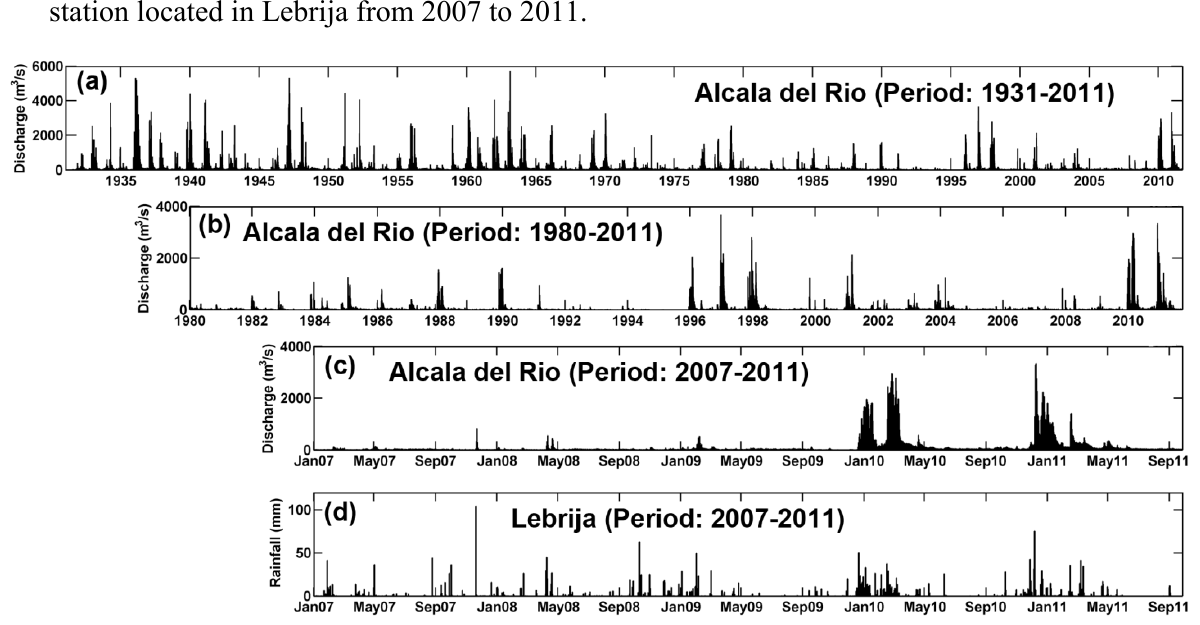
Figure 2. ( a,b,c ) Daily average river discharge (in m 3 /s) from the Alcalá del Río dam during different time periods; ( d ) Daily rainfall (in mm) measured by a meteorological station located in Lebrija from 2007 to